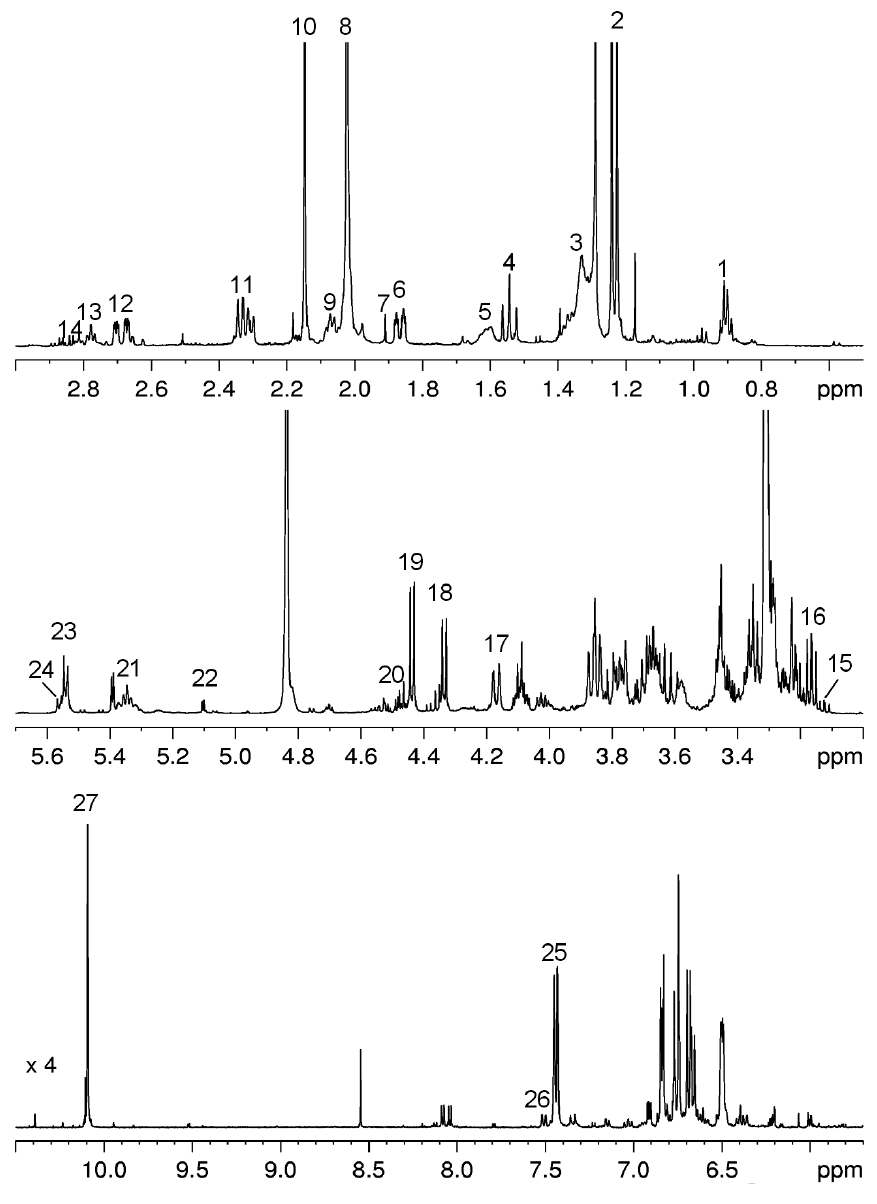
OD at 27 °C. Assignments: 1, CH 3